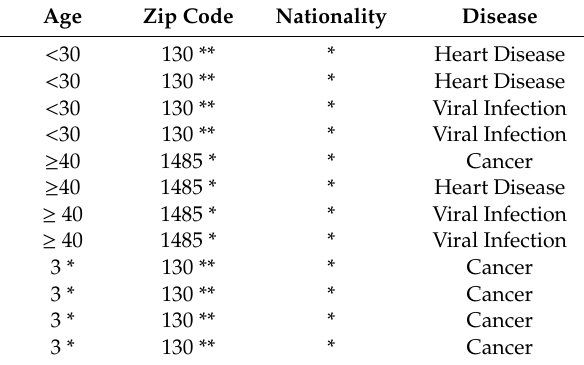
Table 2. Microdata in k -anonymity with k = 4